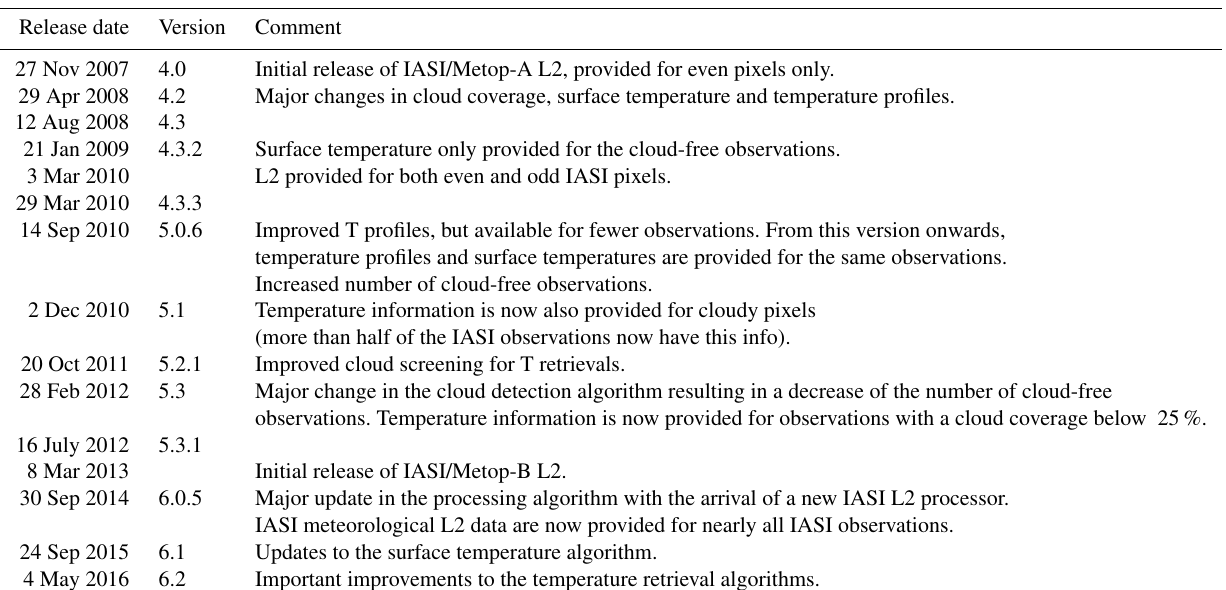
Table 2. Updates to Eumetsat’s operationally distributed IASI L2 temperature and cloud